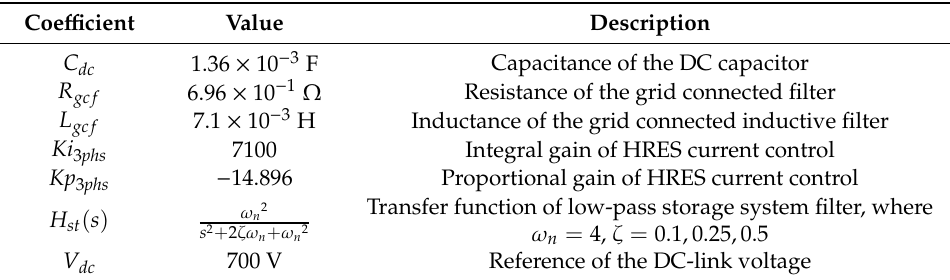
Table 3. Parameters of the DC and three-phase part of the